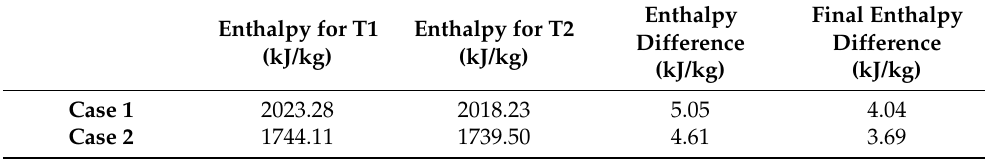
Table 7. Available enthalpy of the external air in each scenario.